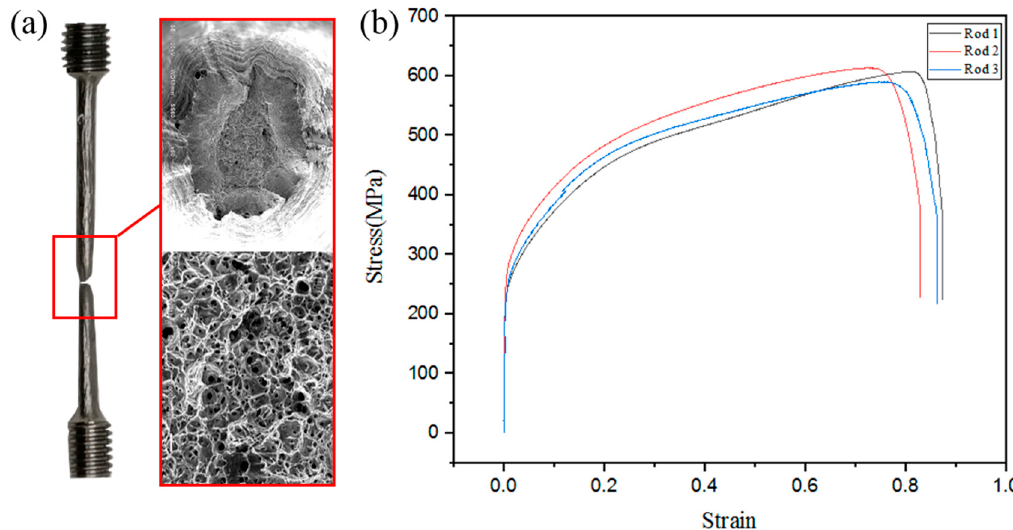
Figure 16. ( a ) Morphology of broken sample and SEM images of fracture surface; ( b ) Stress–strain curve of the tensile specimens.